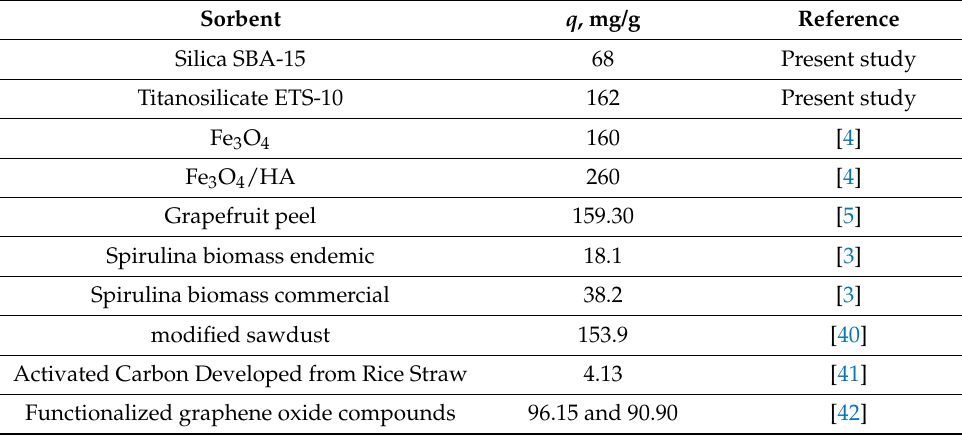
Table 2. The sorption capacity of analyzed sorbents along with literature